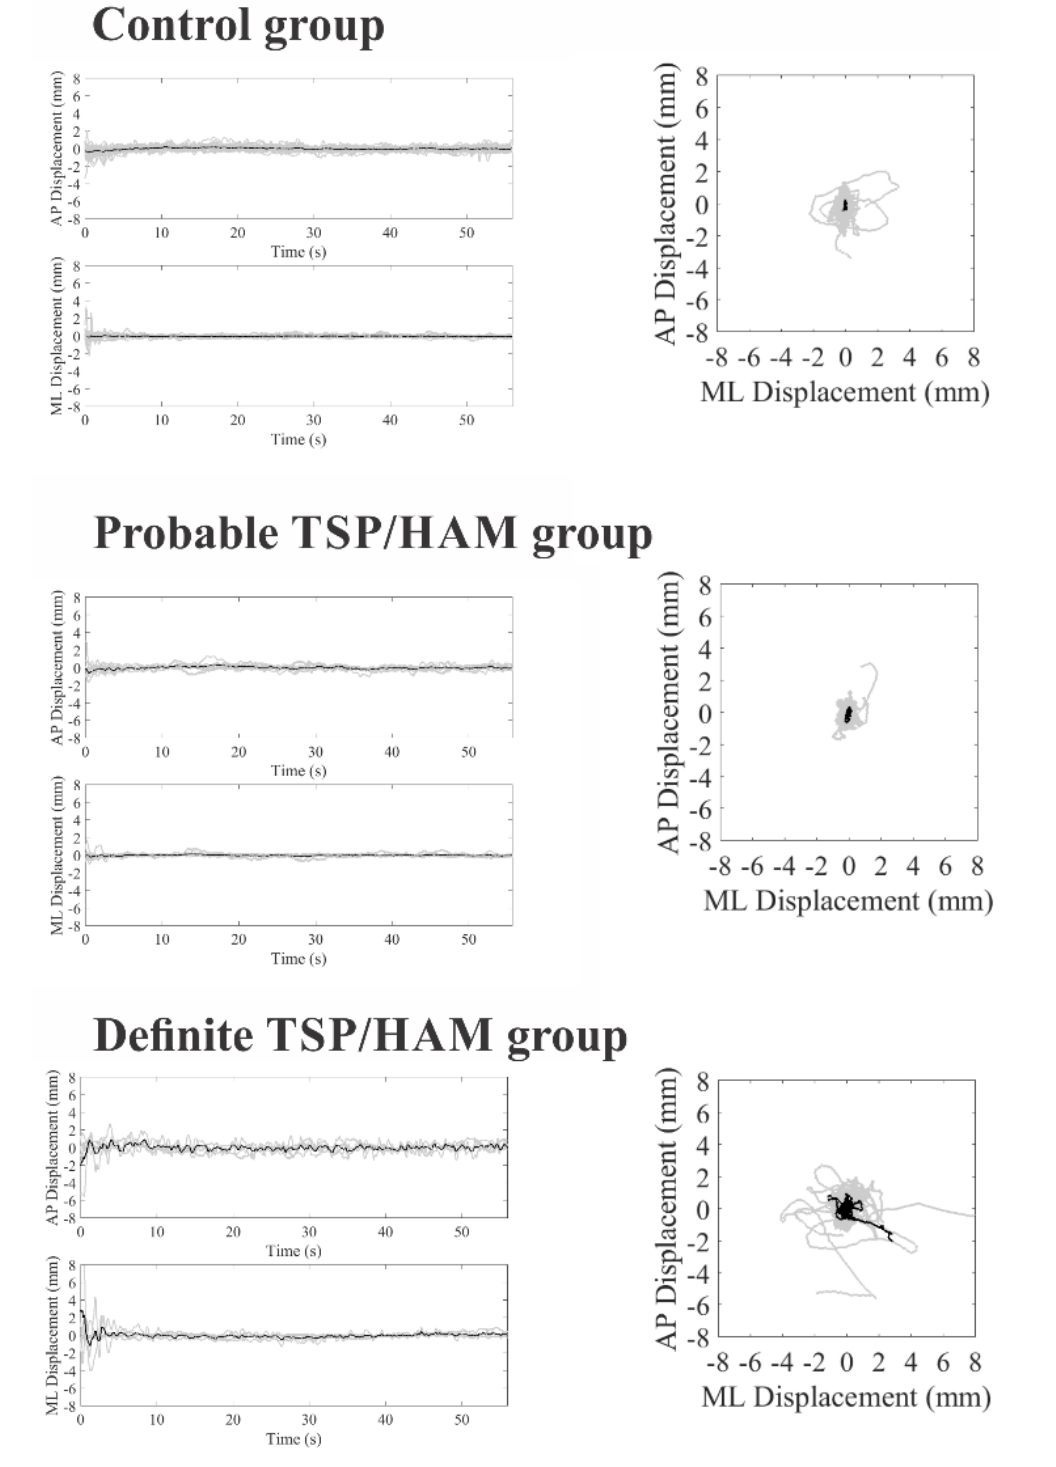
Figure 2. COP displacements in the anteroposterior (AP) and mediolateral (ML) axes as a function of the duration of the test (on left) and statokinesiograms (on right) of the control group, probable TSP/HAM group, and definite TSP/HAM group in the closed-eye condition. Gray recordings represent individual waveforms; black recordings represent grand average recordings.